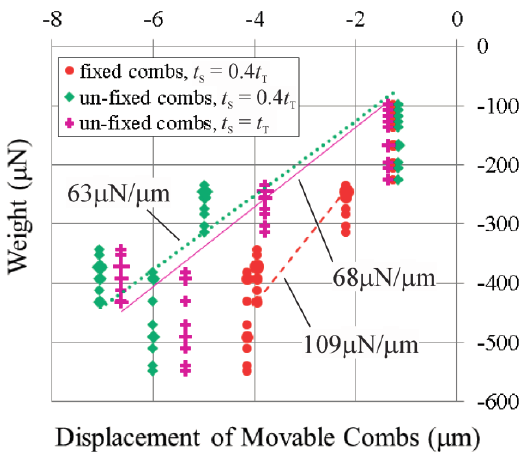
Figure 8. The measured spring constants of the three vertical comb drive designs. A few of the data points have been made larger to indicate that those values of the weights were recorded two or three